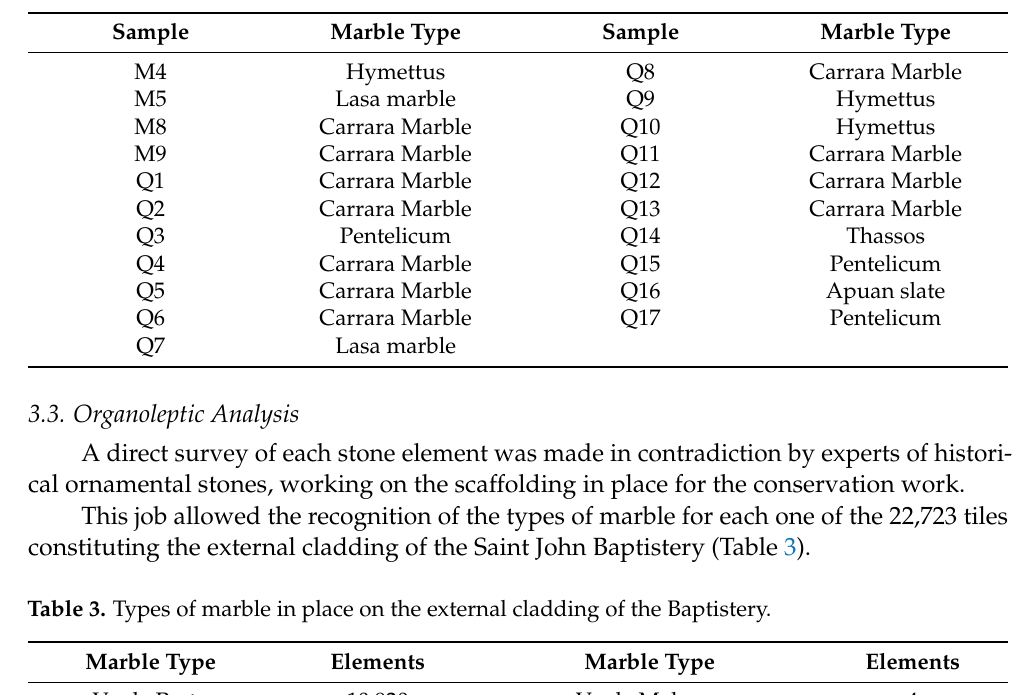
Table 2. Results from the 21 technical analyses performed on the cladding tiles of the